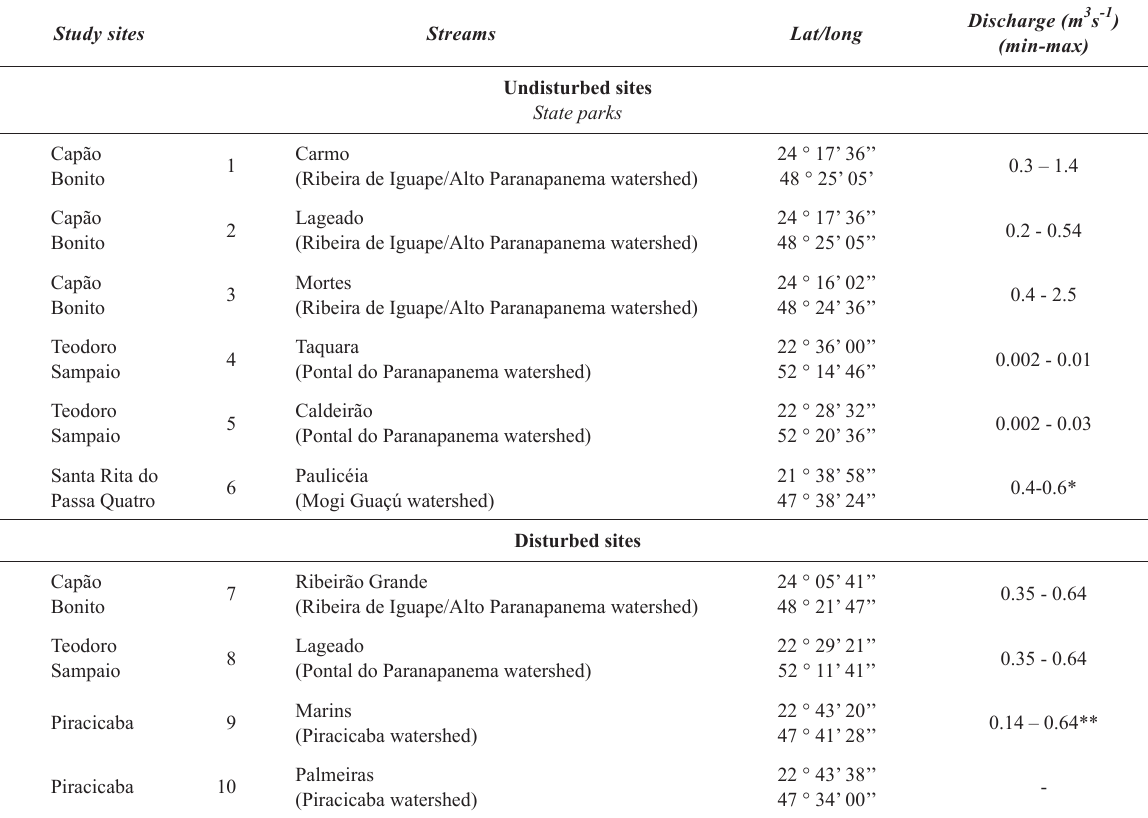
Study area description.